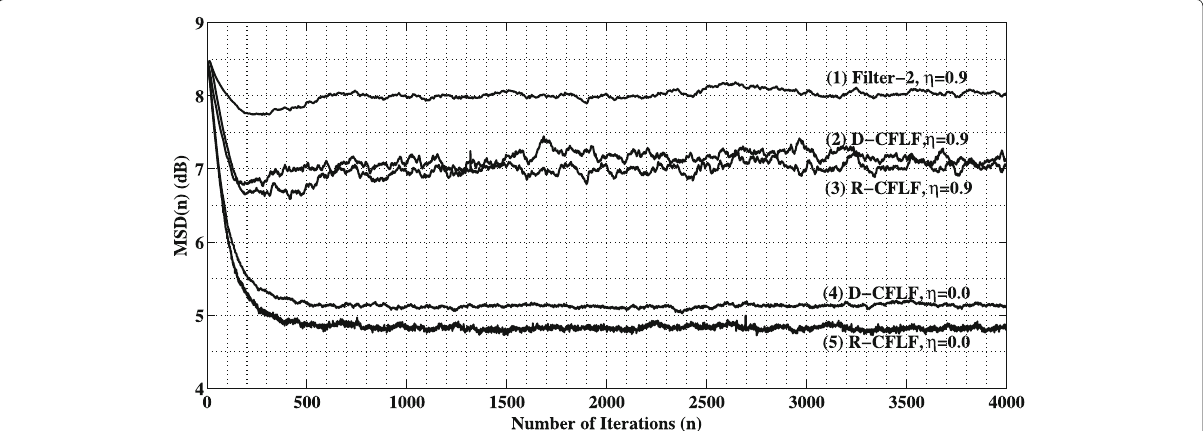
Fig. 12 Effect of coloring the input on the MSD performance of the proposed schemes under faulty operating conditions